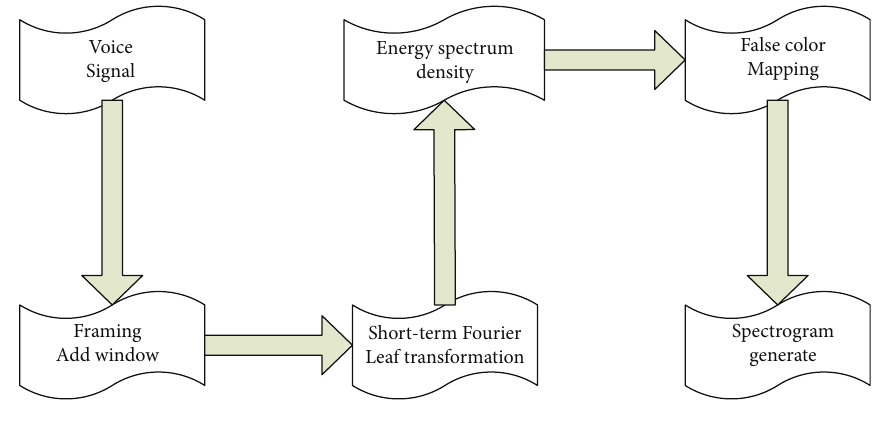
Figure 2: Schematic diagram of the realization of the